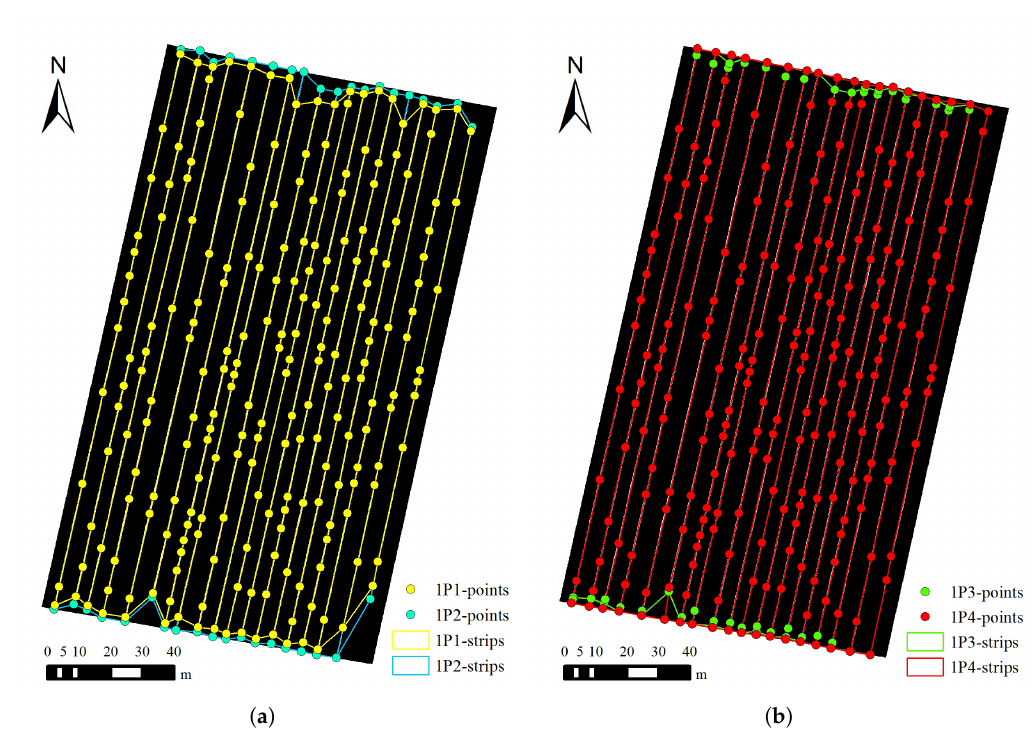
Figure 13. Results of four steps after point reduction and improvement for Plot 1. The binary image of ridge candidates is the background. ( a ) overlaying results of point reduction (P1) and comparison with central points of MER minor axis borders (P2); ( b ) endpoint improvement for corner parts (P3) and other endpoints